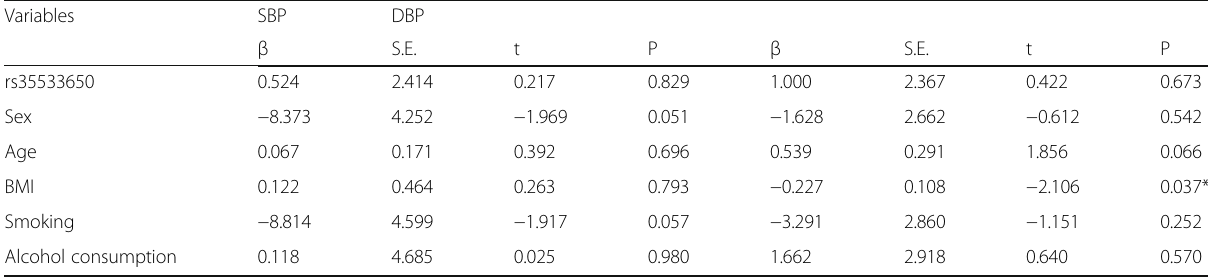
Table 9 Multivariate linear regression analysis of the rs35533650 polymorphism with systolic pressure and diastolic pressure Variables SBP DBP β S.E. P β